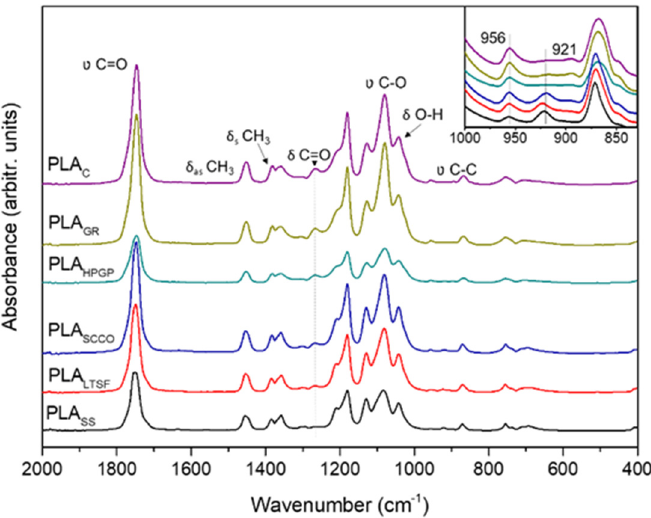
Figure 3. FTIR spectra of the PLA discs subjected to the different sterilisation treatments with absorption bands identified: PLA GR , PLA SCCO , PLA LTSF , PLA SS and PLA HPGP together with the untreated PLA disc as control, PLA C . Amplification of the 400–2000 cm − 1 wavenumber range in the inset with the two main peaks identified.